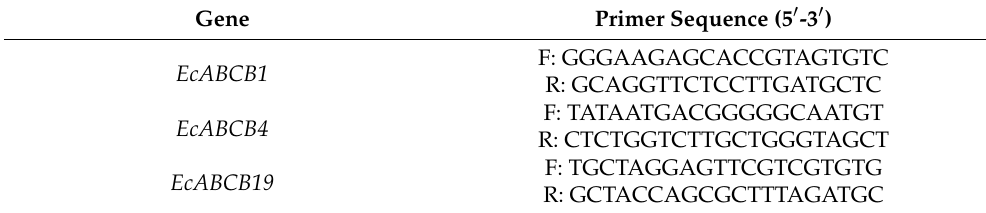
Table 2. Gene expression in E. crus-galli var. zelayensis was determined by qRT-PCR.